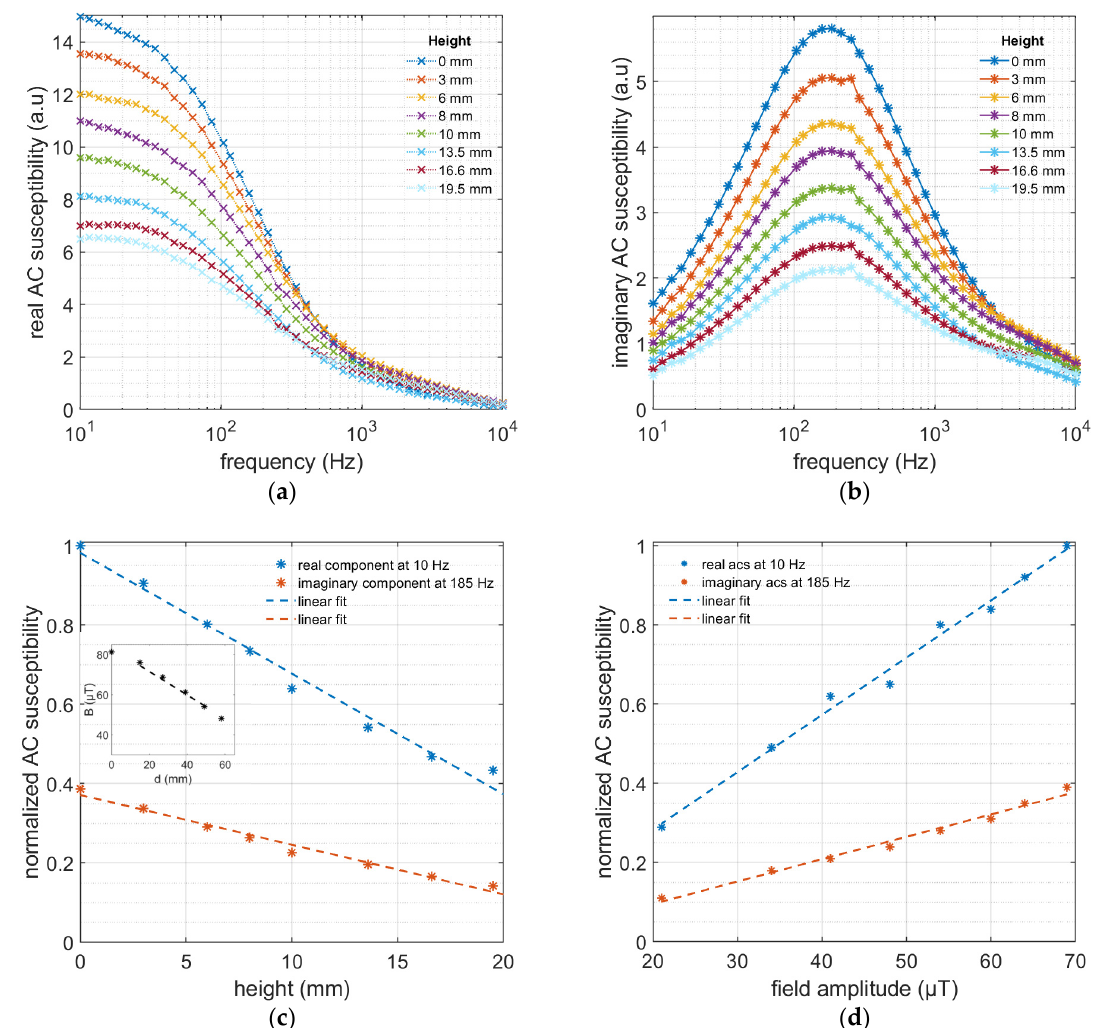
Figure 2. ( a ) The real and ( b ) imaginary components of magnetic AC susceptibility are plotted as a function of frequency at different distances with respect to the detection coil for the 100 nm MNP tracer. ( c ) Normalized real (at 10 Hz) and imaginary (at 185 Hz) components of the magnetic AC susceptibility of the 100 nm MNPs are plotted against the height measured from the detection coil. The lines are linear fits to the data. The inset shows the relation between the field amplitude and the distance from the center of the excitation coil and is measured using a Tesla meter. The line shows the linear dependence in the distance range where the MNP sample is placed. ( d ) Normalized real (at 10 Hz) and imaginary (at 185 Hz) components of magnetic AC susceptibility of the 100 nm MNPs versus the field amplitude scale linearly with the field amplitude in the range of 20–70 µT.